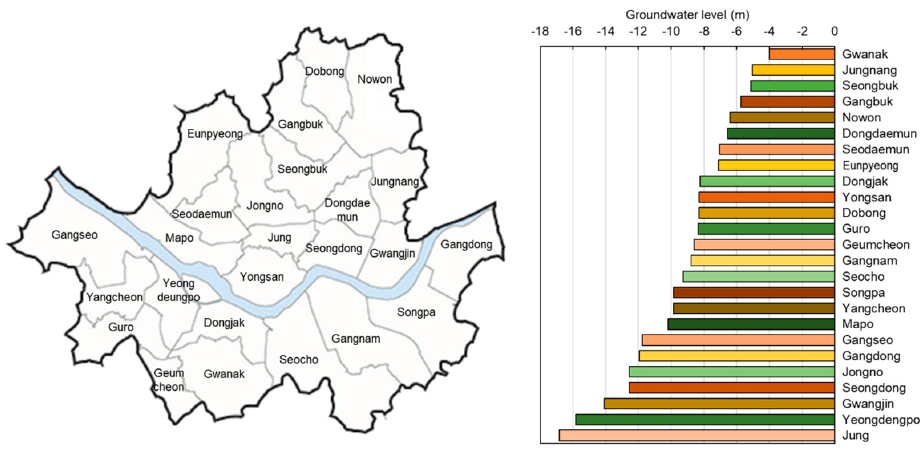
Figure 1. The depth of the groundwater levels observed in the districts of Seoul, South Korea.